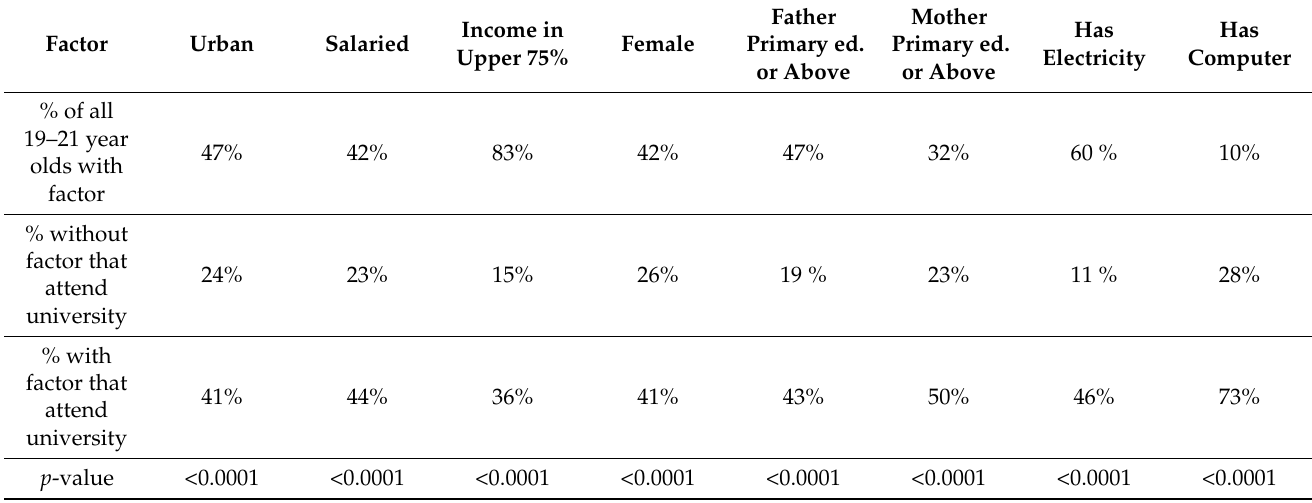
Table 2. Socieconomic factors associated with university attendance among 19–21-year-olds, using data from CBS (2014).